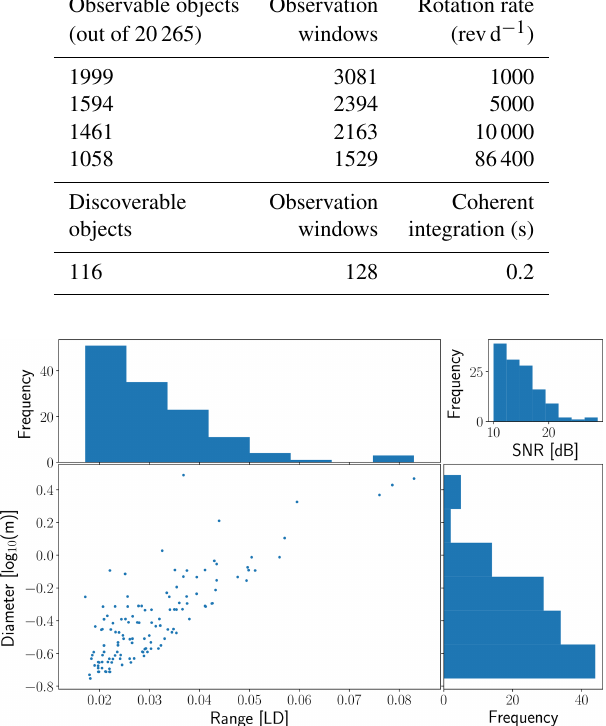
Figure 12. Distribution of ranges and sizes of possible discovery windows. Also included is the distribution of peak SNR for these